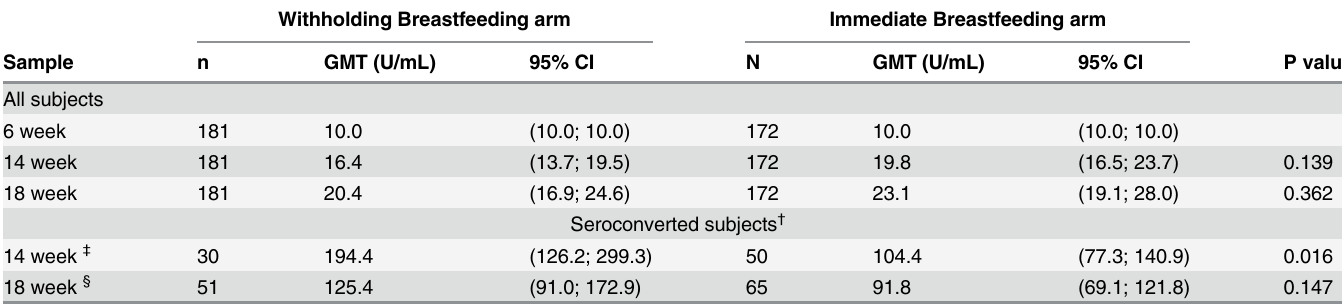
Table 4. Anti-Rotavirus IgA Geometric Mean Titers